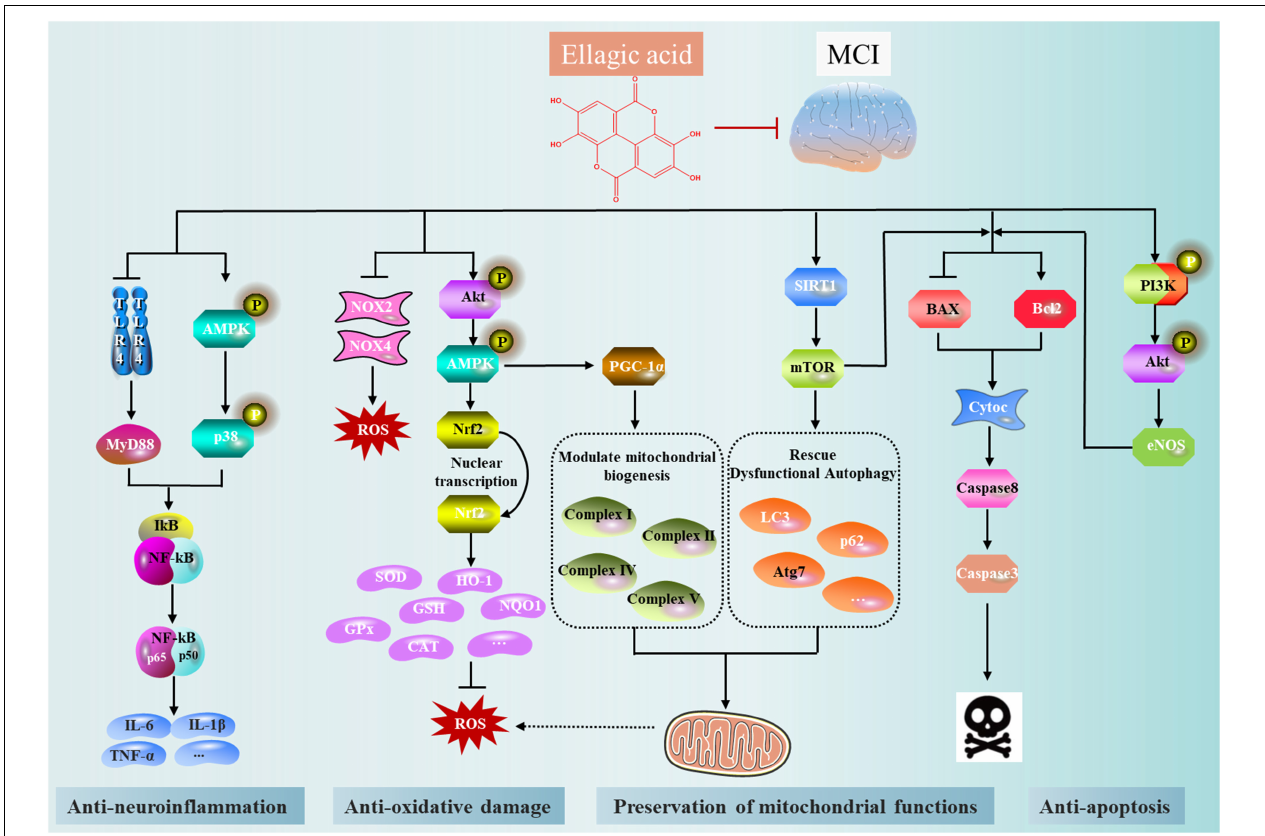
FIGURE 4 | The main mechanism network of anti-mild cognitive impairment (MCI) effect of ellagic acid (EA).